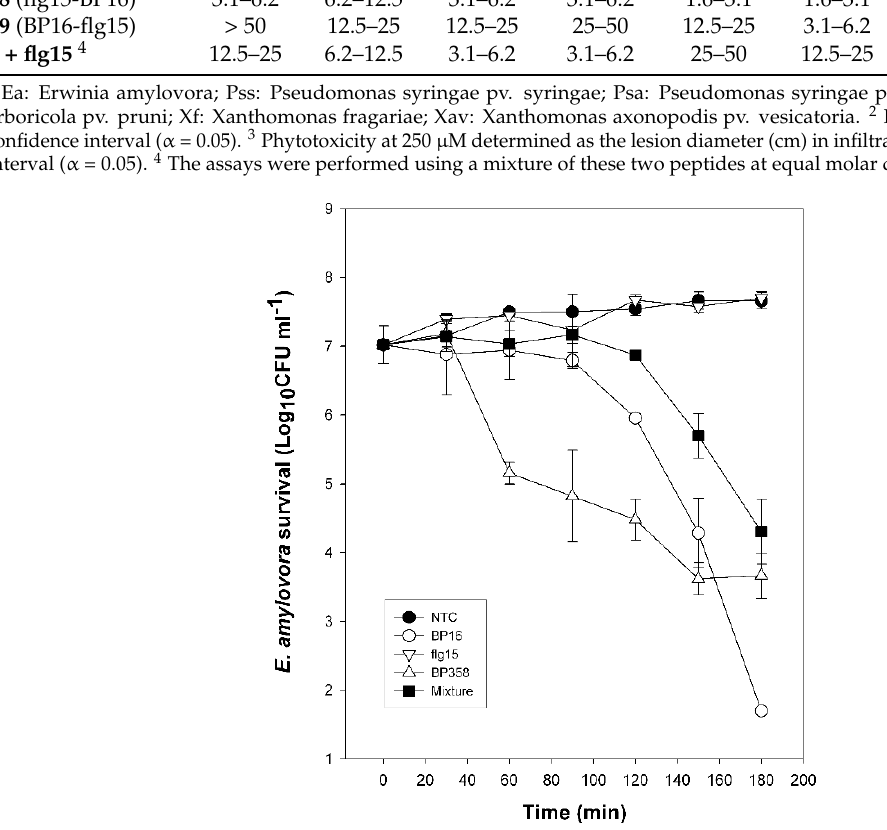
Figure 1. Kinetics of survival of E. amylovora in the presence of peptides. Bacterial suspensions were untreated (NTC) or treated with BP16 (50 µM), flg15 (100 µM), BP358 (6.2 µM), or a mixture of flg15 and BP16 at equal molar quantities (25 μM) (Mixture). Viable cells were determined at different time intervals.